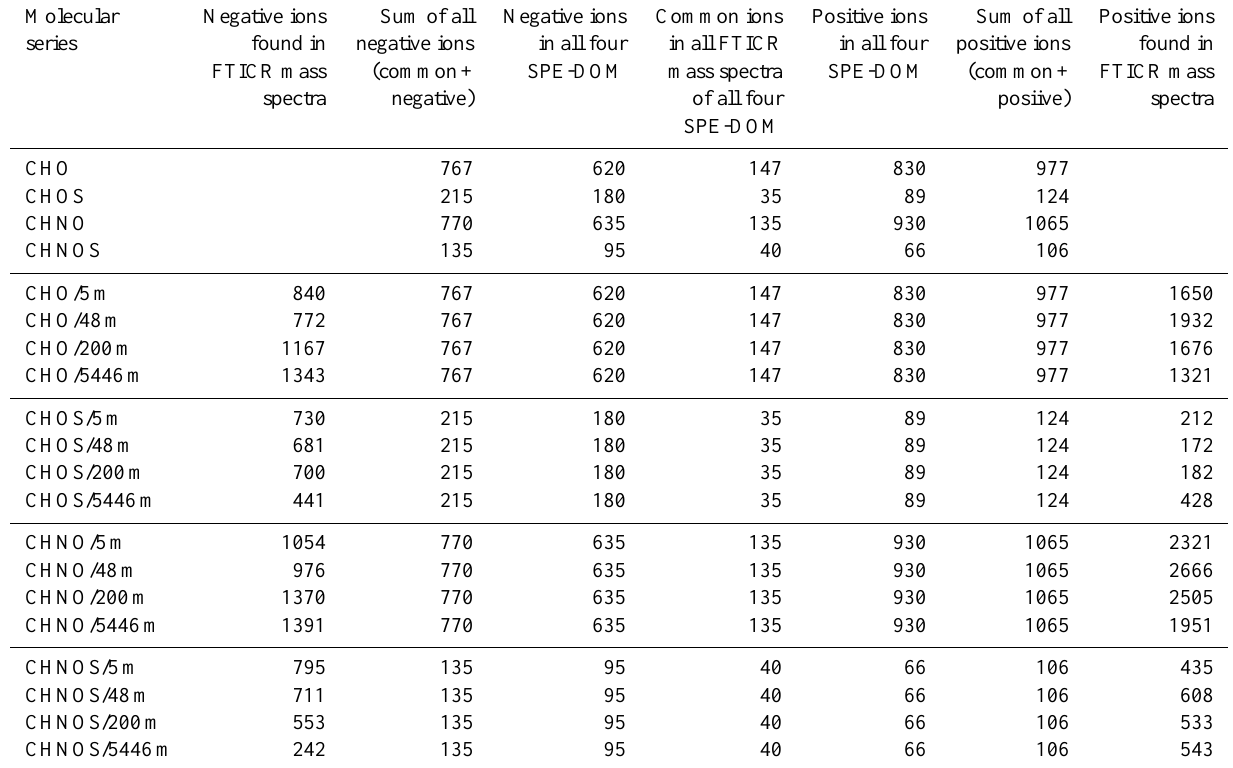
Table 6. Counts of common and unique ions found in all FTICR mass spectra of the four marine SPE-DOM sorted according to molecular